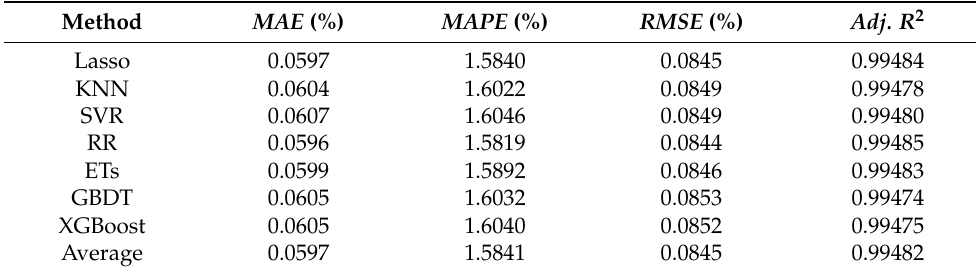
Table 4. Performance comparison of the different fusion